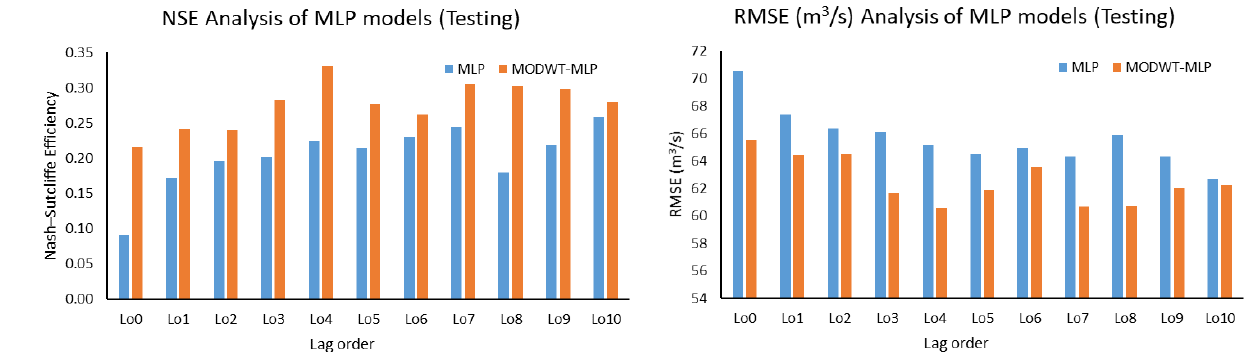
Figure 11. Performance evaluation of the MLP and MODWT-MLP models.